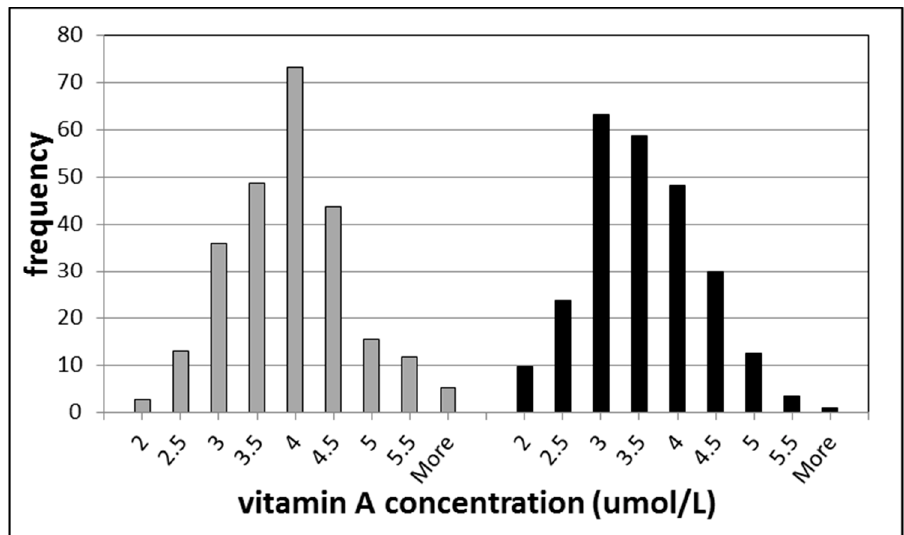
Figure 1. Histograms of vitamin A (retinol) concentrations in healthy individuals. The left part represents the data for men and the right part for women.